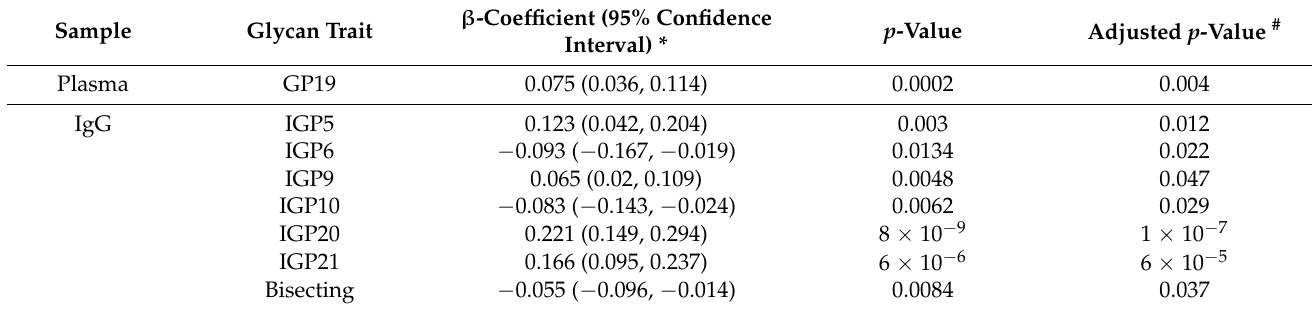
Table 2. Differences of total plasma proteins and IgG N -glycosylation between patients with AF and healthy controls. Only statistically significant traits and N -glycan structures are shown in the